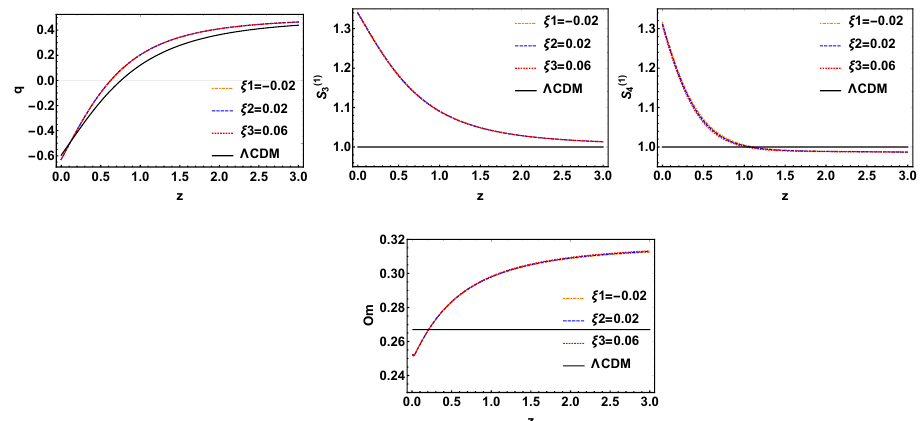
Figure 11. The evolution trajectories of q , S IwCDM 4 model with variable ξ and fixed w = − 1.1, where ξ is taken separately − 0.02, 0.02, 0.06. The evolution curve of Λ CDM is also shown in these sets of figures.